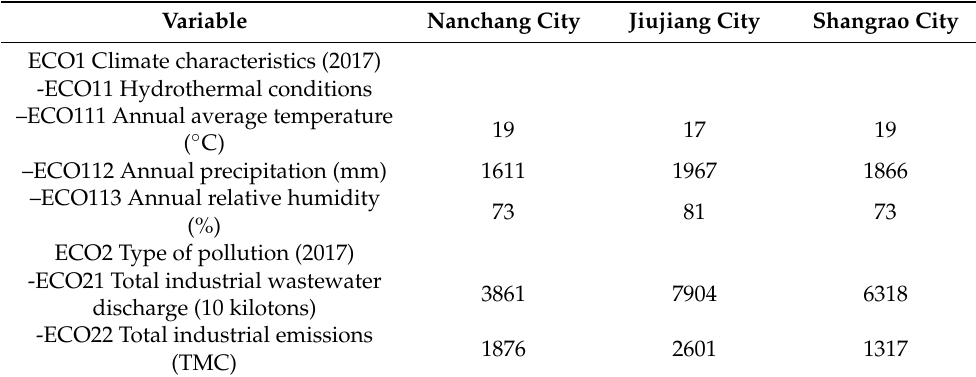
Table 2. Comparison of Poyang Lake wetland Ecosystem